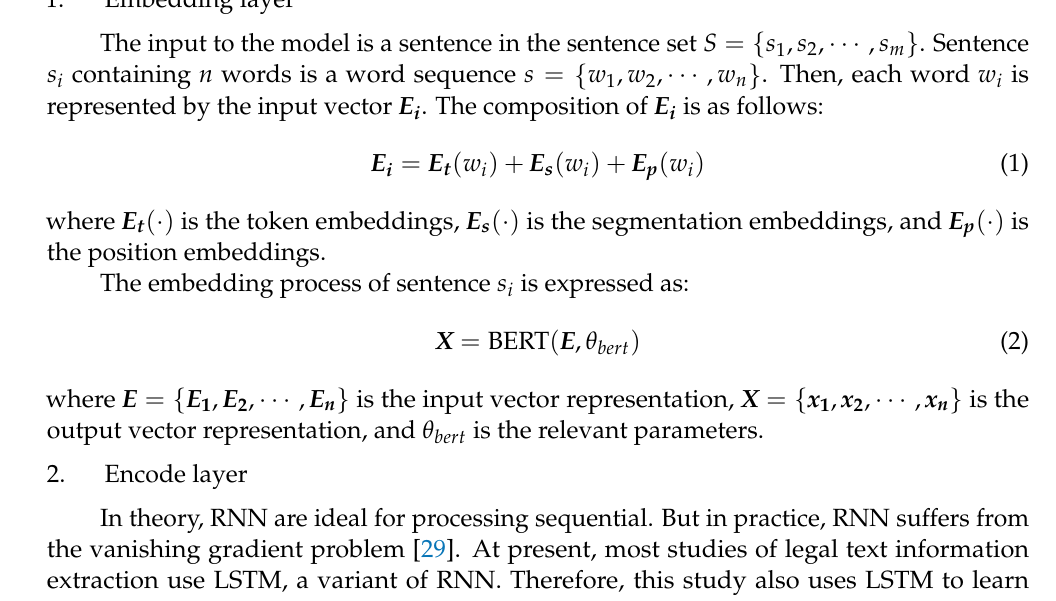
Figure 4. The architecture of the deep learning-driven extractor.